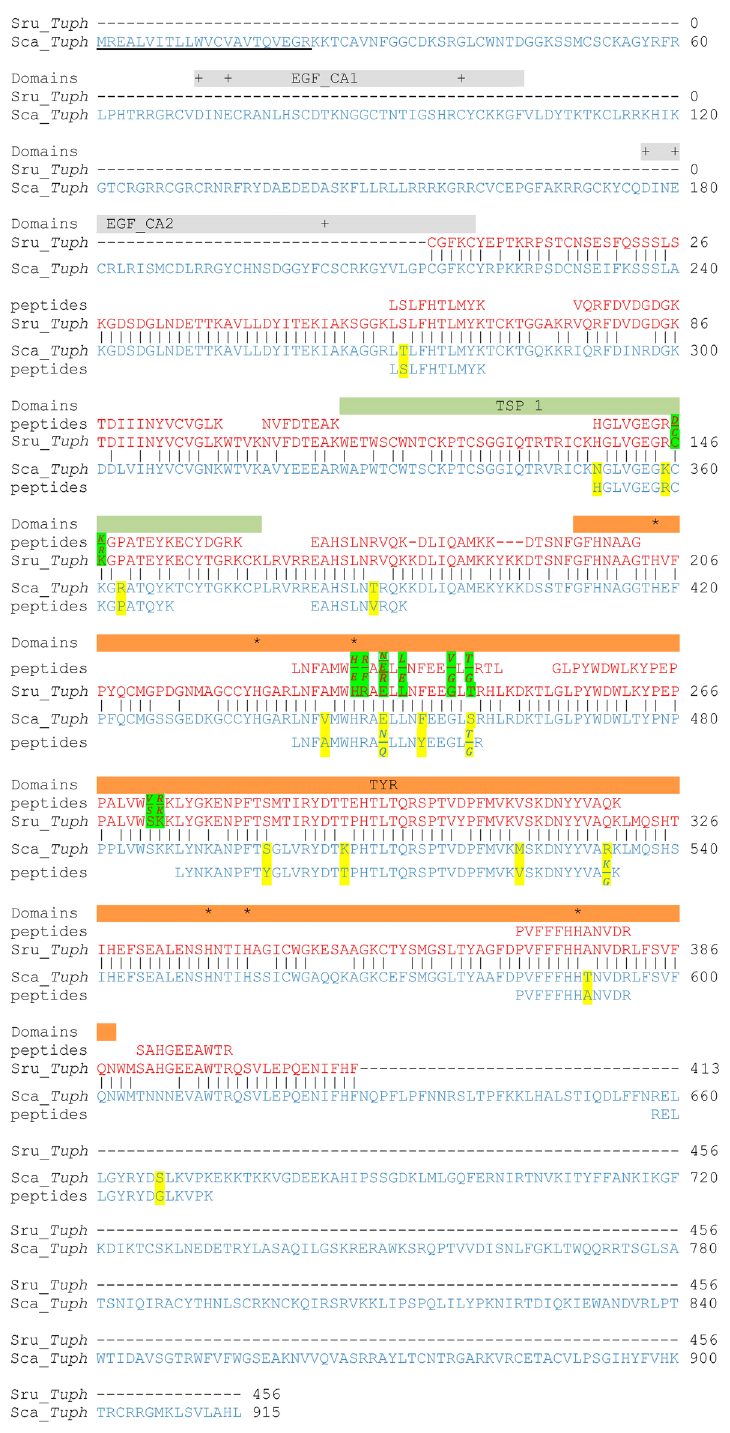
Figure 3. Alignment of tryptic peptides from 48 kDa protein band with in silico translated Tuphoxin transcripts. Transcripts of S. rustica— Sru_ Tuph (red), and S. canopus —Sca_ Tuph (blue). Vertical bars show aa that are identical for two species. Tryptic peptides are merged in longer sequences, with aa substitutions compared to translated transcripts highlighted in green (Sru_ Tuph ) and yellow (Sca_ Tuph ). The predicted signal peptide is underlined. Predicted conserved domains are marked by rectangles: grey (calcium-binding EGF- like—EGF_CA), green (thrombospondin first type repeat—TSP1), and orange (tyrosinase—TYR). Plus signs (+) indicate calcium-binding sites, the asterisks (*) indicate the active site amino